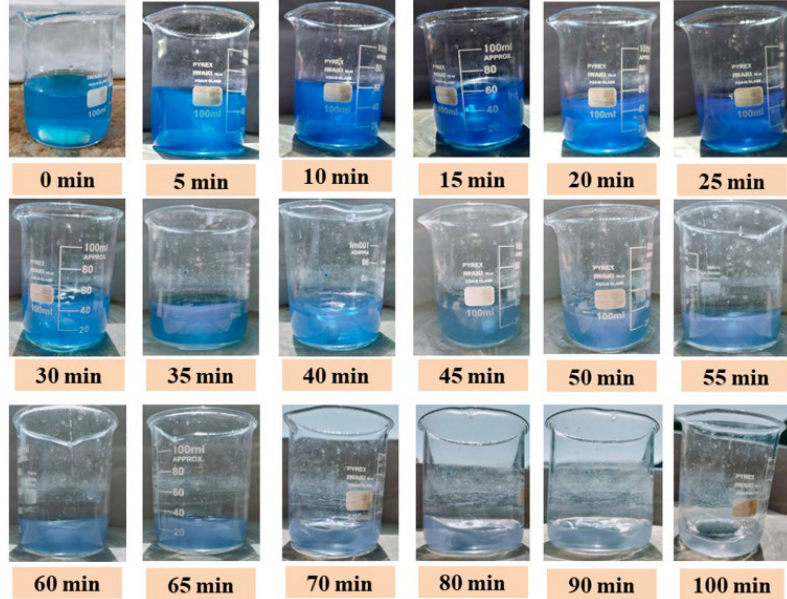
Figure 10. Naked eye evidence of the decolorization of NBS dye.